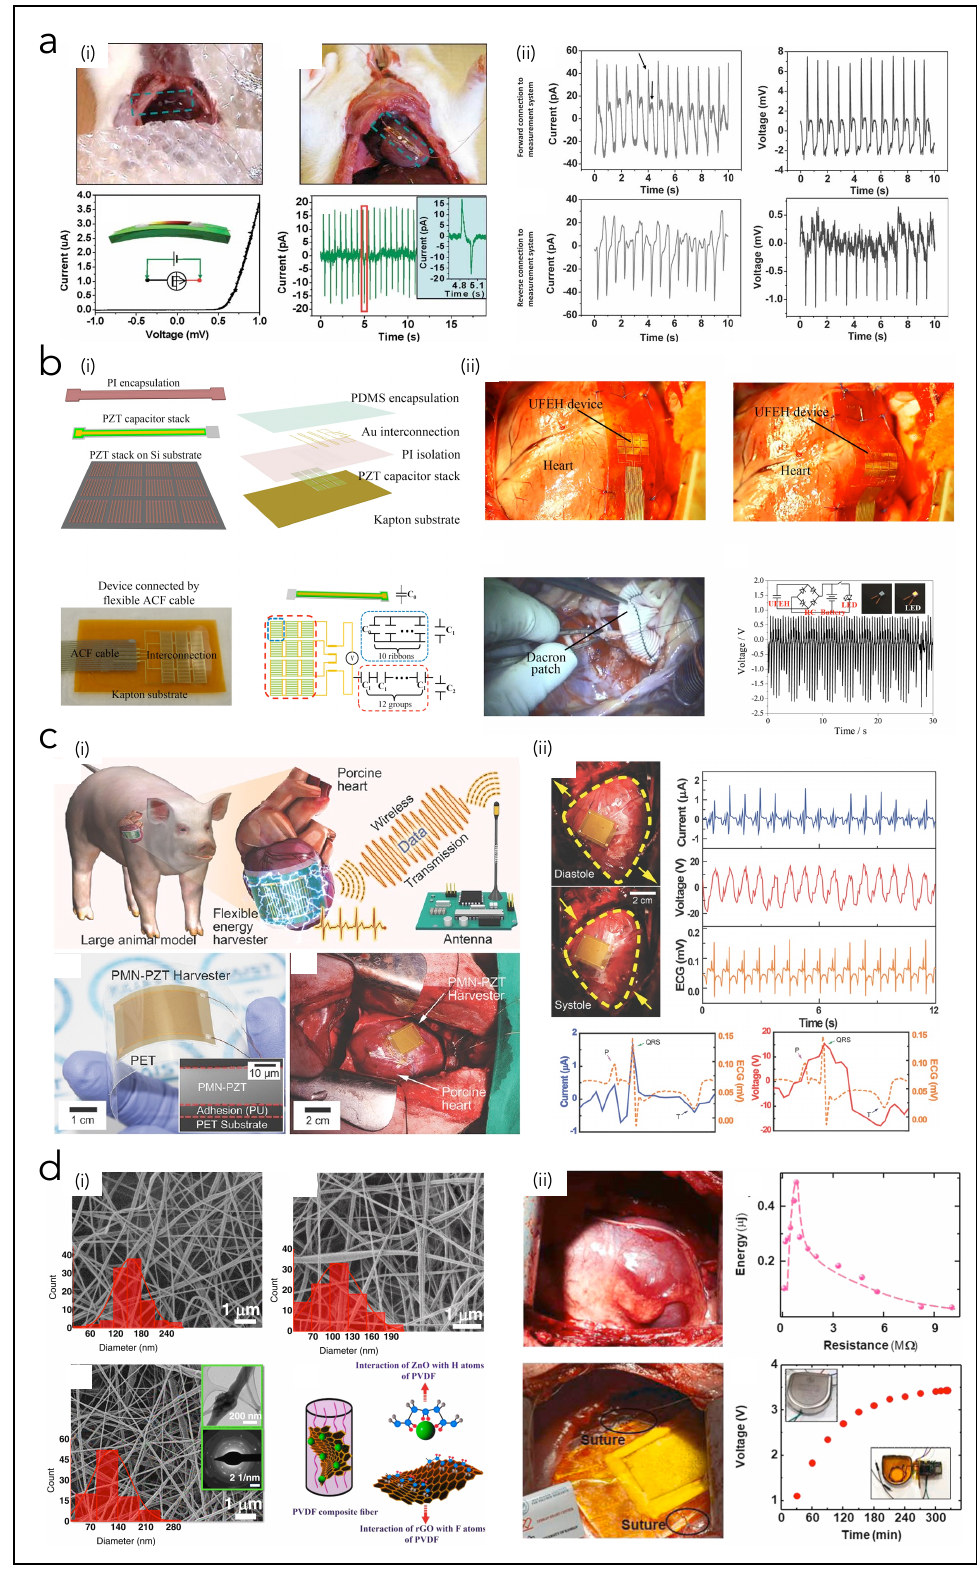
Figure 3. Examples of PNGs for scavenging heart energy. ( a ) PNG attached to a live rat’s diaphragm and heart, with the I-V characteristics (i) and the in vivo testing for energy harvesting from the rat’s heartbeat (short-circuit current and open-circuit voltage signals in forward and reverse connection